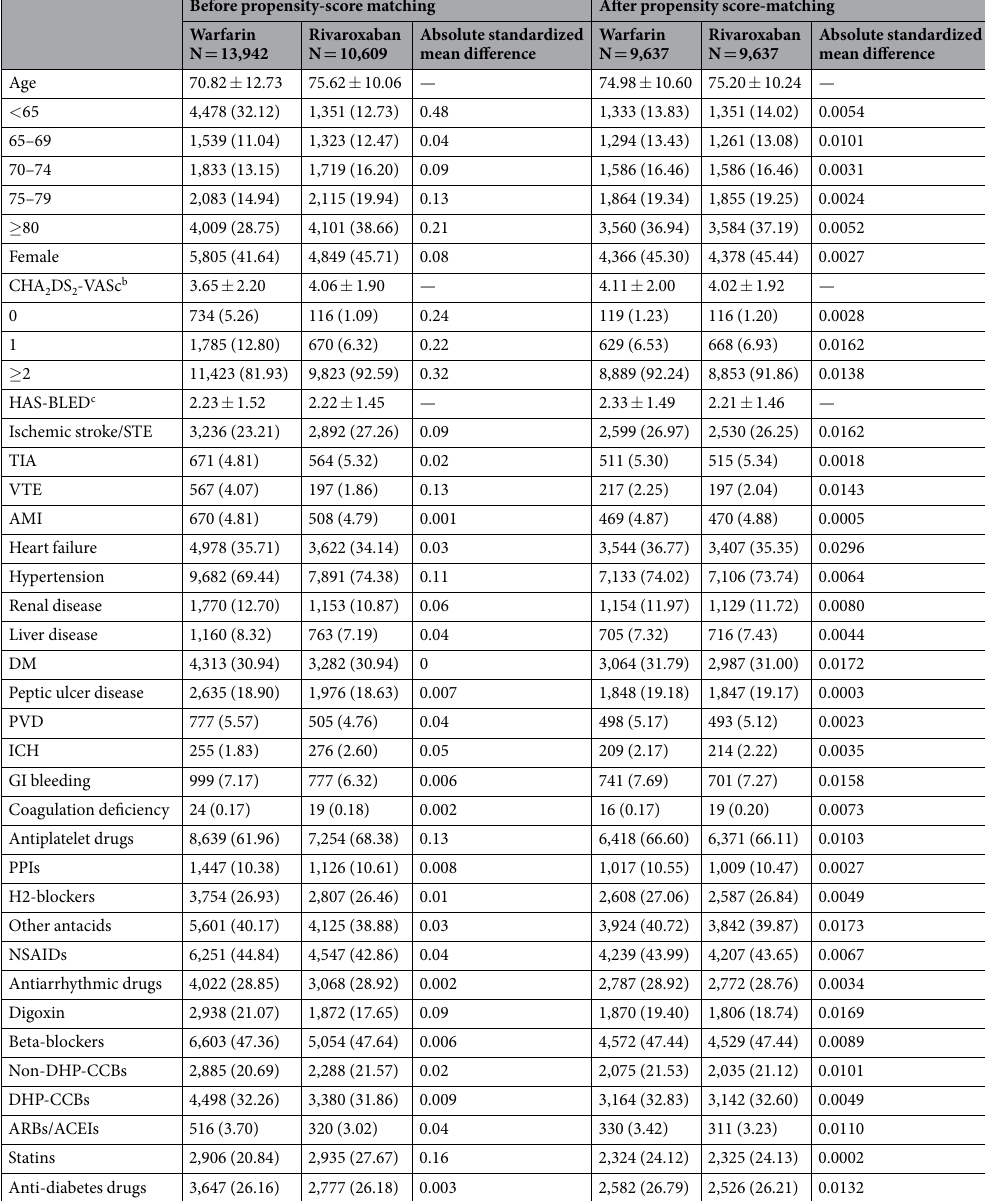
Table 1. Basic characteristics before and after propensity-score matching a . a Data was expressed as mean ± standard deviation or number (percentage) unless specified otherwise. The co-morbid diseases were identified from diagnoses within 1 year before the first date of NOAC prescription. b CHA 2 DS 2 -VASc scores ranged from 0 to 9; a higher score indicates a higher risk of stroke or thromboembolism. One point was assigned for congestive heart failure, hypertension, age between 65–74 years, diabetes mellitus, and vascular disease. Two points were assigned for age ≥ 75 years, previous stroke, transient ischemic attack, and systemic thromboembolism. c HAS-BLED scores ranged from 0 to 9; a higher score indicating a higher risk for major bleeding. One point was assigned for hypertension, renal disease, liver disease, stroke, bleeding, age > 65 years, treatment with platelet inhibitors or non-steroidal anti-inflammatory drugs, and alcohol abuse. Abbreviations: ACEIs: angiotensin converting enzyme inhibitors; AMI: acute myocardial infarctions; ARBs: angiotensin receptor II blockers; CCBs: calcium channel blockers; DHP: dihydropyridine; DM: diabetes mellitus; GI: gastrointestinal; H2: histamine receptor 2; ICH: intracranial hemorrhage; NSAIDs: non-steroidal anti-inflammatory drugs; PPIs: proton pump inhibitors; PVD: peripheral vascular disease; STE: systemic thromboembolism; TIA: transient ischemic attack; VTE: venous